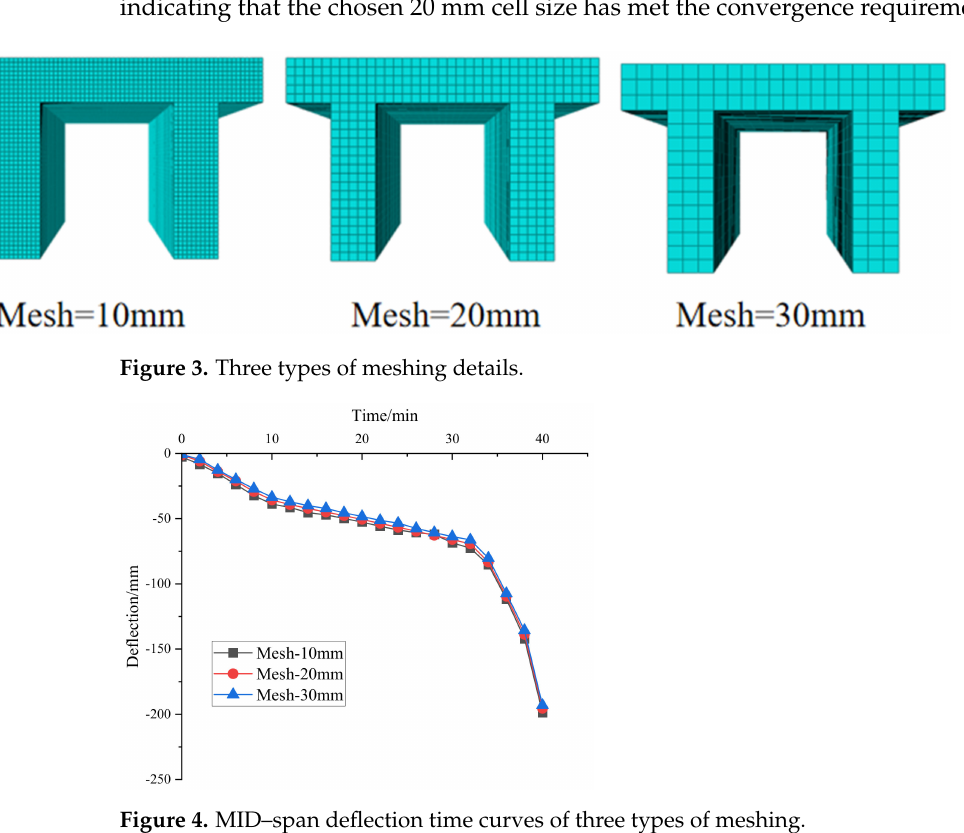
Figure 4. MID–span deflection time curves of three types of meshing.